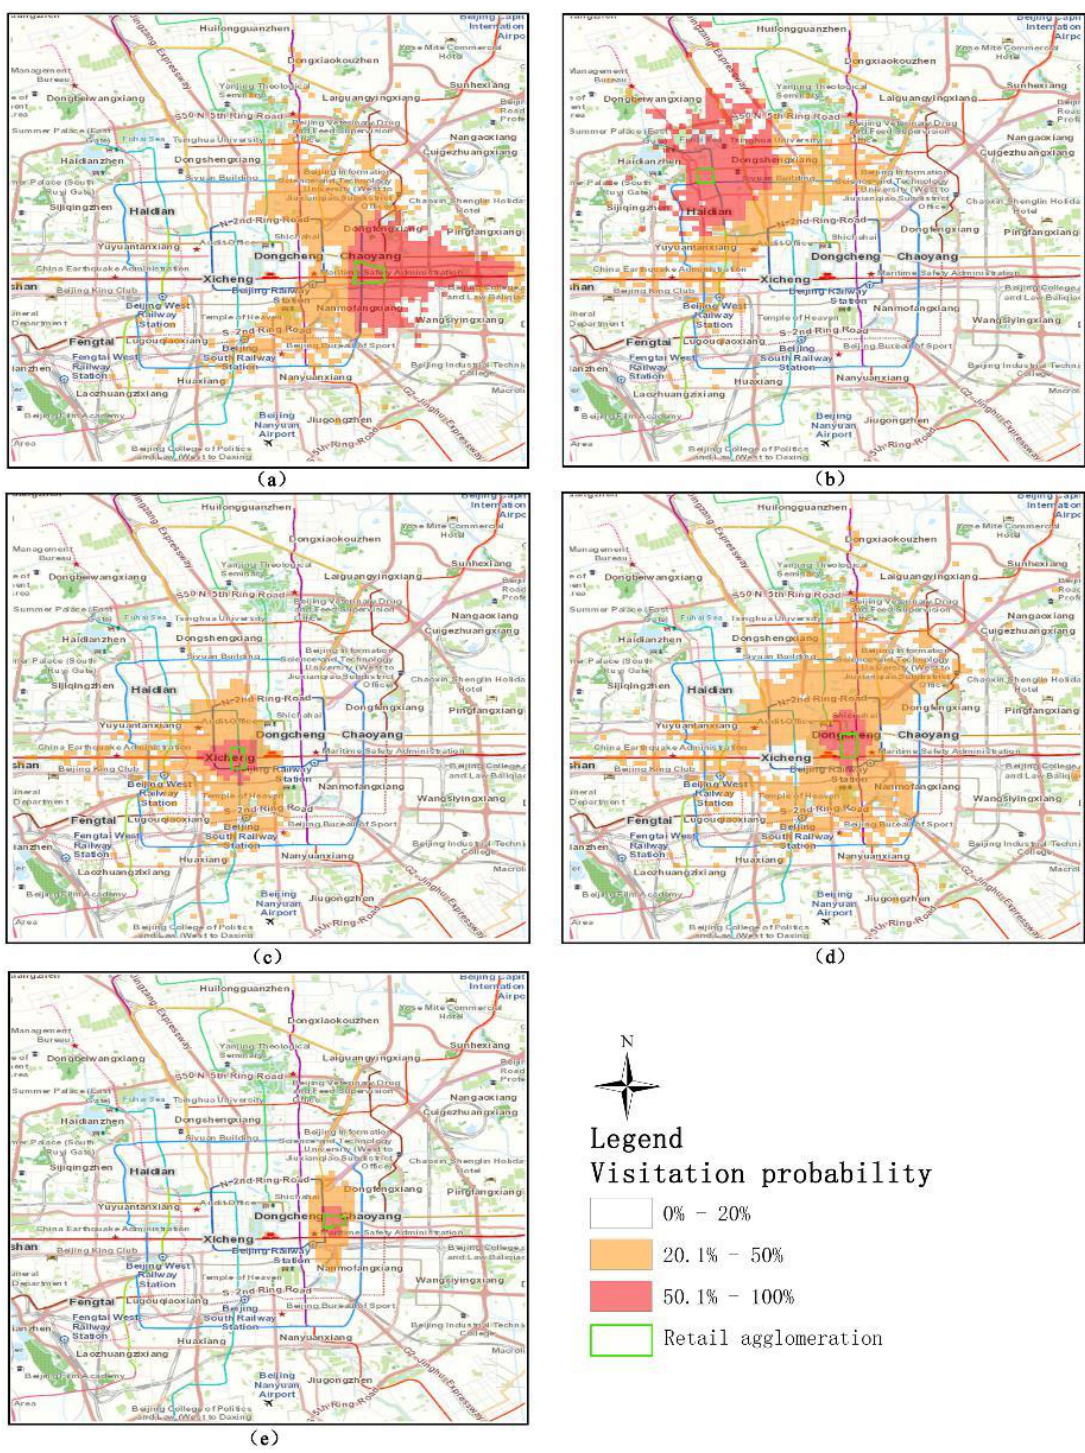
Figure 5. The trade area of each retail agglomeration: ( a ) the trade area of G retail agglomeration; ( b ) the trade area of Z retail agglomeration; ( c ) the trade area of X retail agglomeration; ( d ) the trade area of W retail agglomeration; ( e ) the trade area of C retail agglomeration.